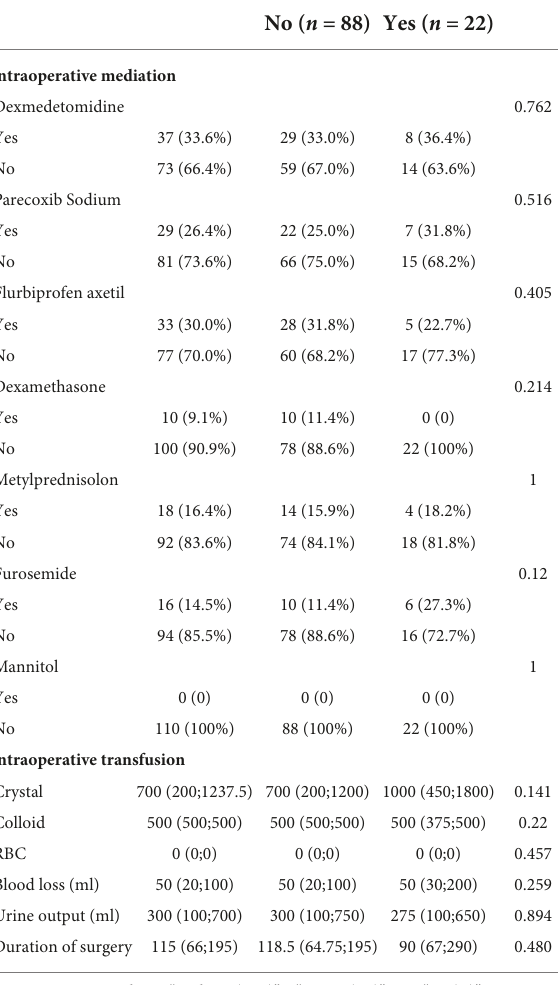
TABLE 3 Outcomes of patients between two groups.